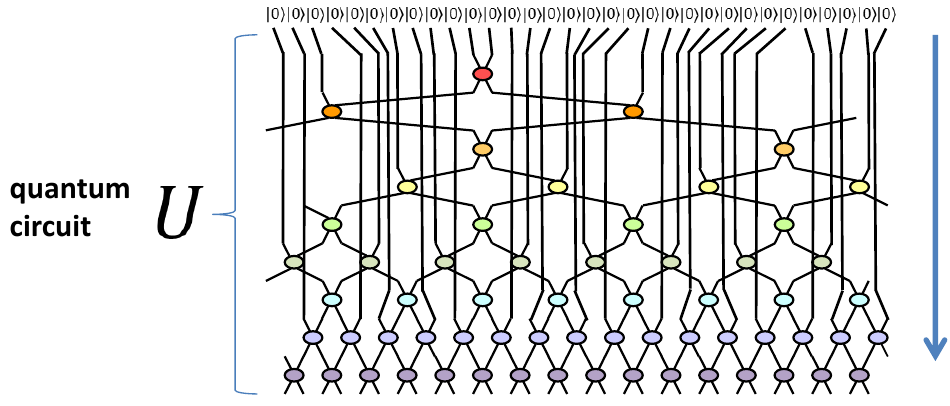
Figure 8 . Illustration of MERA as a quantum circuit. Starting from the tensor product state j 0 i j 0 i : : : j 0 i (top), the sequential application of entanglers and isometries (colored dots) e(cid:14)ciently generates the ground state (bottom). These operators can be thought of as unitary gates (although not simple elementary gates), and hence the tensor network can be thought of as the quantum circuit that connects the reference (product) and target (ground) states 0 and 1 . Figure courtesy of Guifr(cid:19)e Vidal